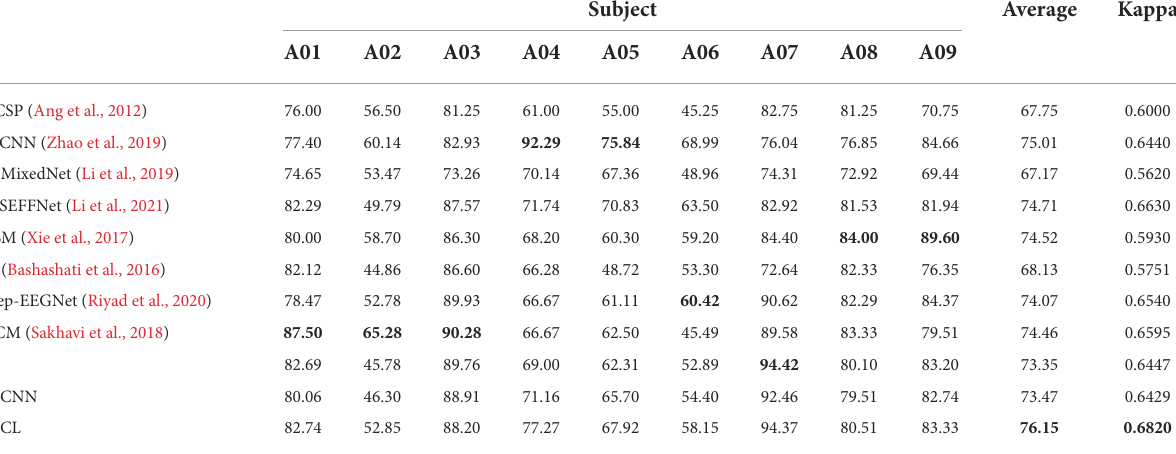
TABLE 3 Performance comparison of different approaches on four MI classes BCI competition IV dataset IIa, where highlighted results indicate the best values for each